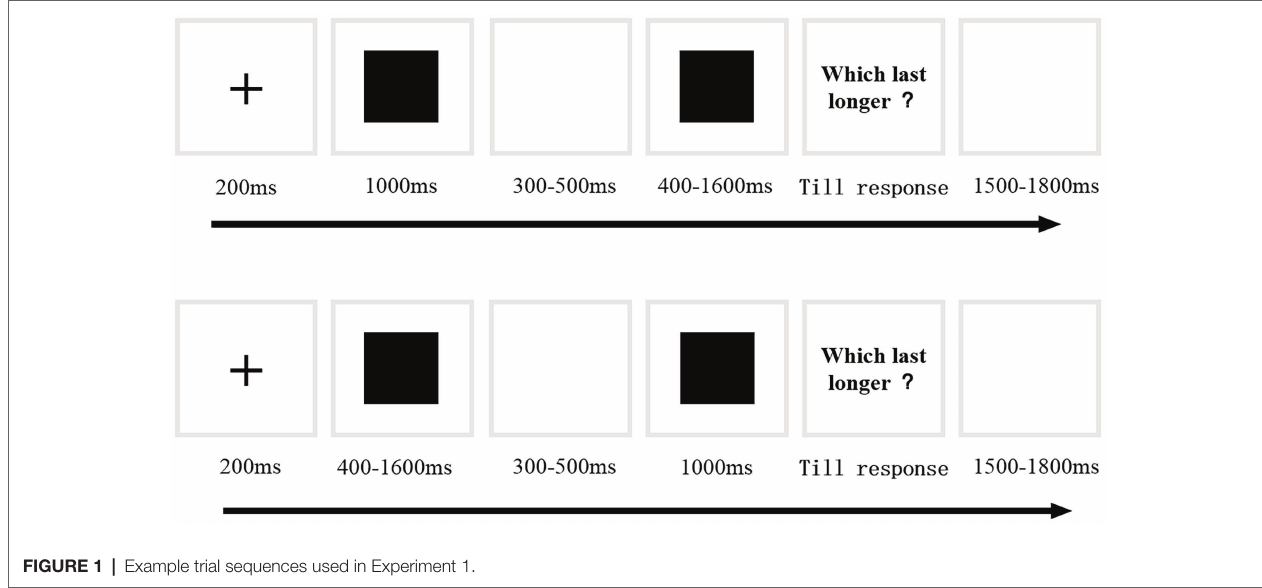
FIGURE 1 | Example trial sequences used in Experiment 1.